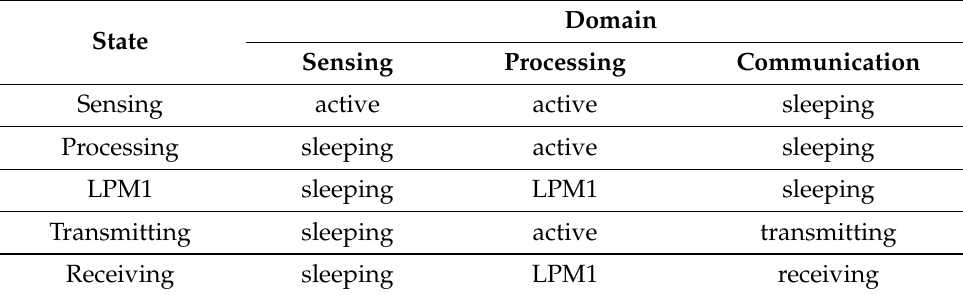
Table 1. Set of states of the Markov